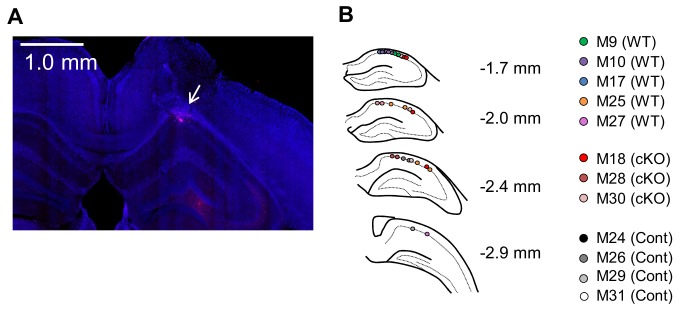
Histological verification of recording sites in the CA1.(A) An example of a hippocampal slice with DiI pasted at the tip of the electrode and DAPI staining. White arrows indicate inserted points. (B) Electrode tracks are represented by colored dots corresponding to the subjects. The recording electrodes for M9, M10, M18, M24, and M26 were silicon probes (A4-2tet-5mm-150-200-121-H32, NeuroNexus), and M17, M25, M28, M29, M30 and M31 were nichrome tetrodes. All of the electrodes were set on the microdrives and adjusted to the targeting cites.